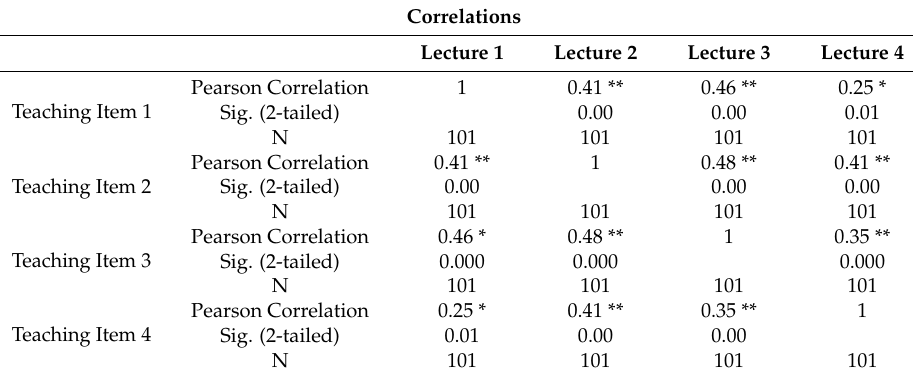
Table 4. Intercorrelations of the Students’ Responses to the Four Lectures.